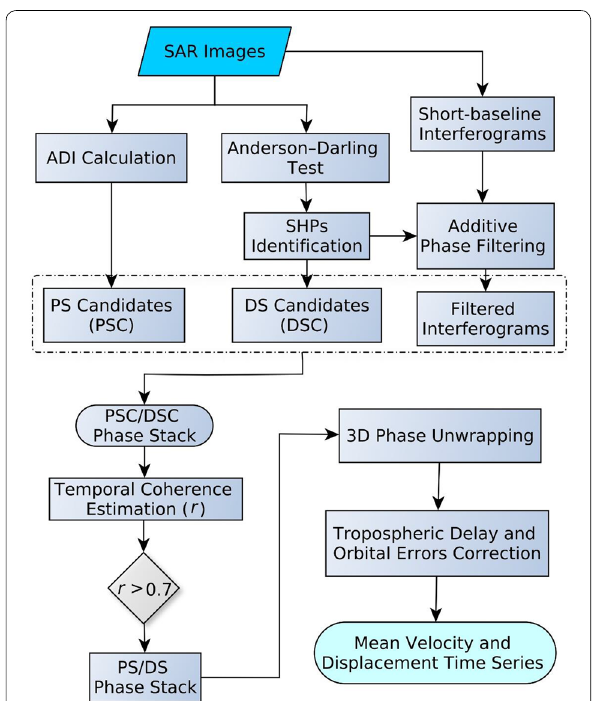
Fig. 3 Flowchart of the SAR data processing in this study. Note the acronyms with ADI Amplitude Dispersion Index, SHP statistically homogeneous pixels, PS persistent scatterers, DS distributed scatterers, 3D